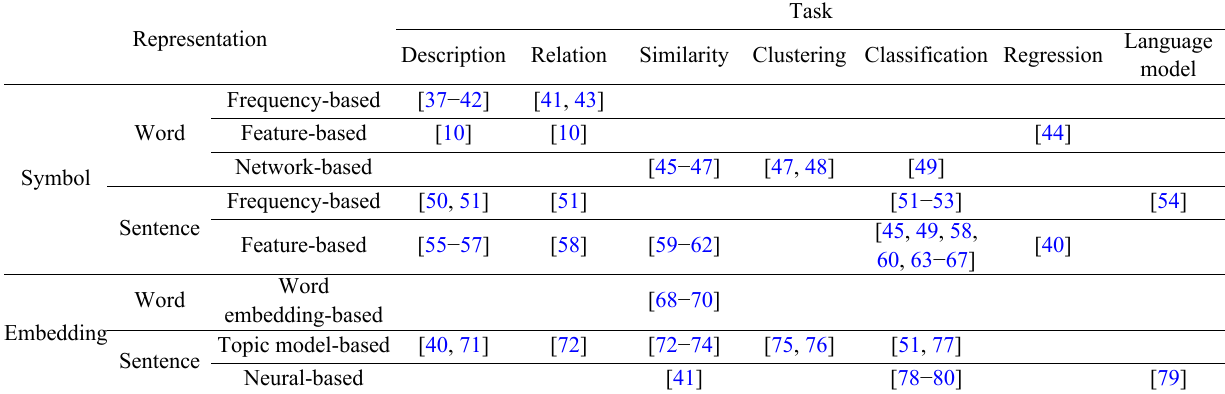
Table 2 Applications of symbol-based and embedding-based text